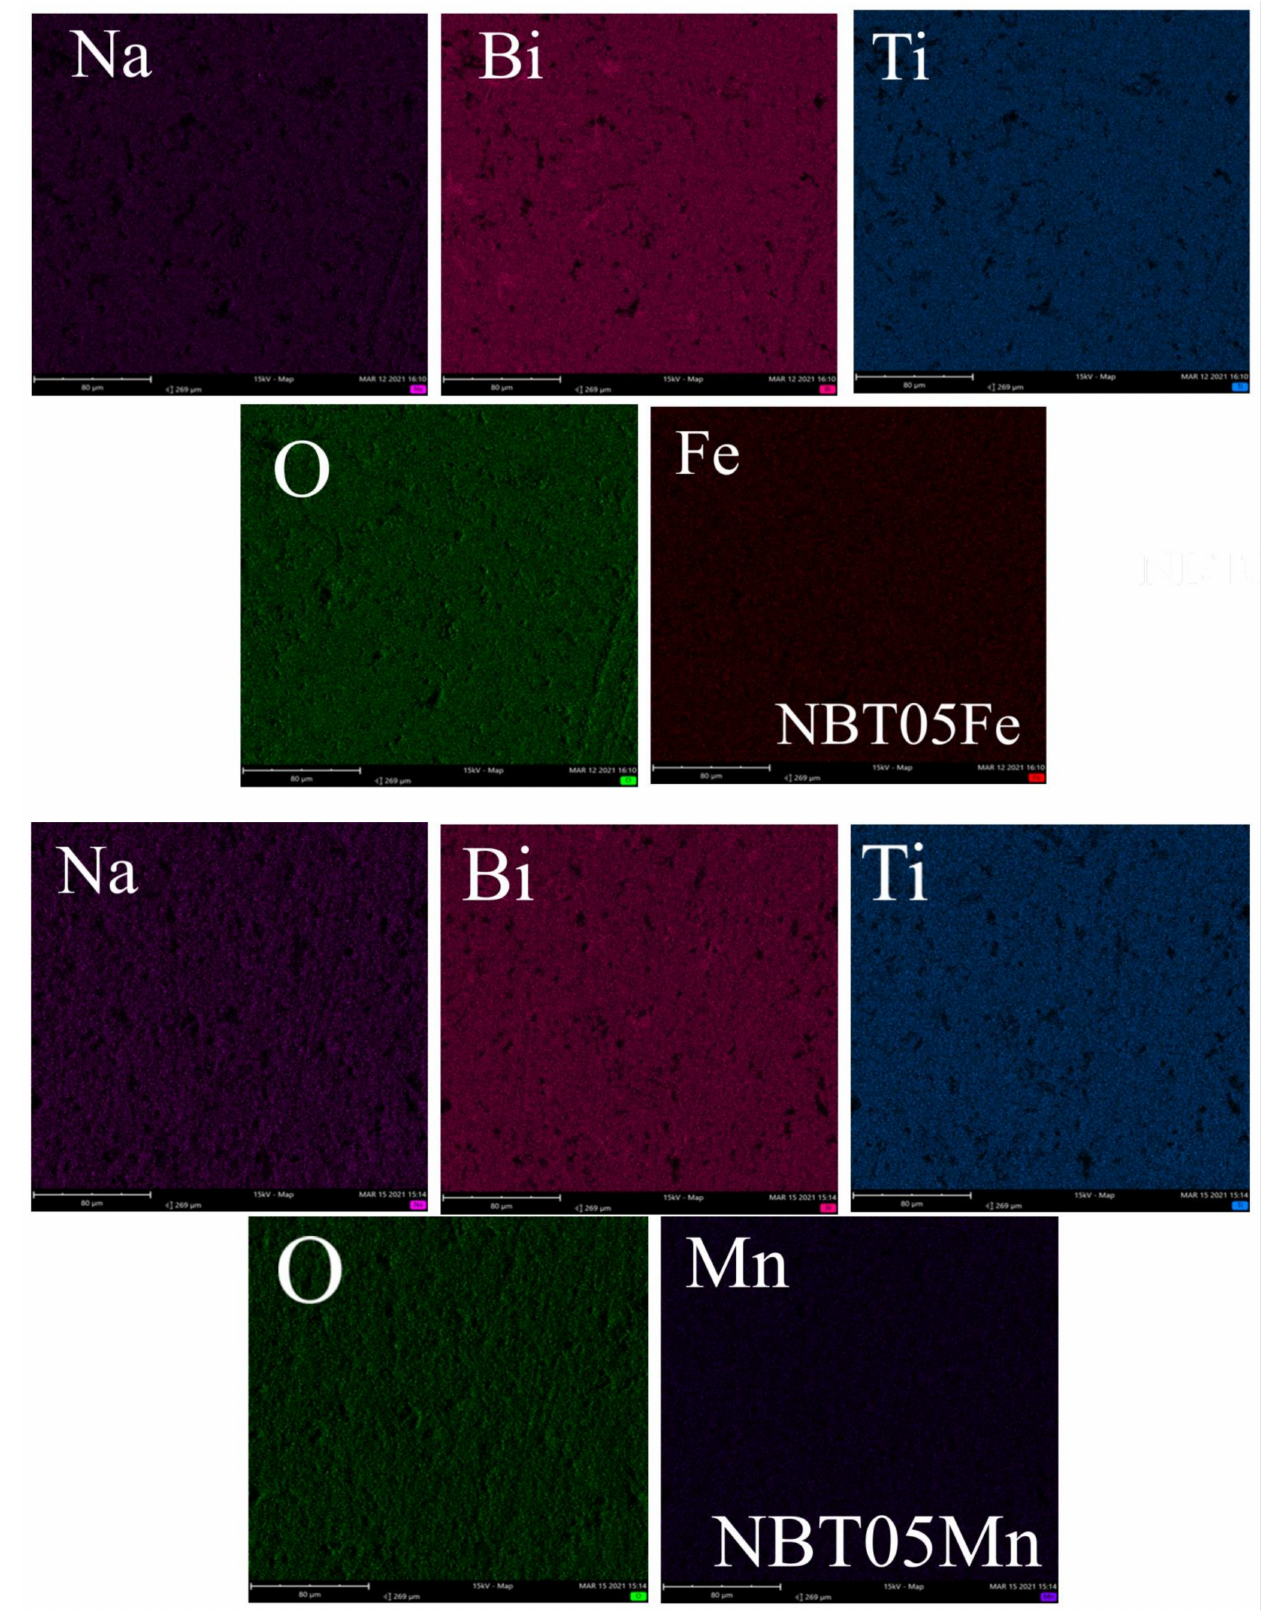
Figure 1. SEM micrographs of the surface of the investigated samples and SEM-EDS elemental mapping for selected samples: NBT ( a ), NBT05Mn ( b ), NBT1Mn ( c ), NBT05Fe ( d ) and NBT1Fe ( e